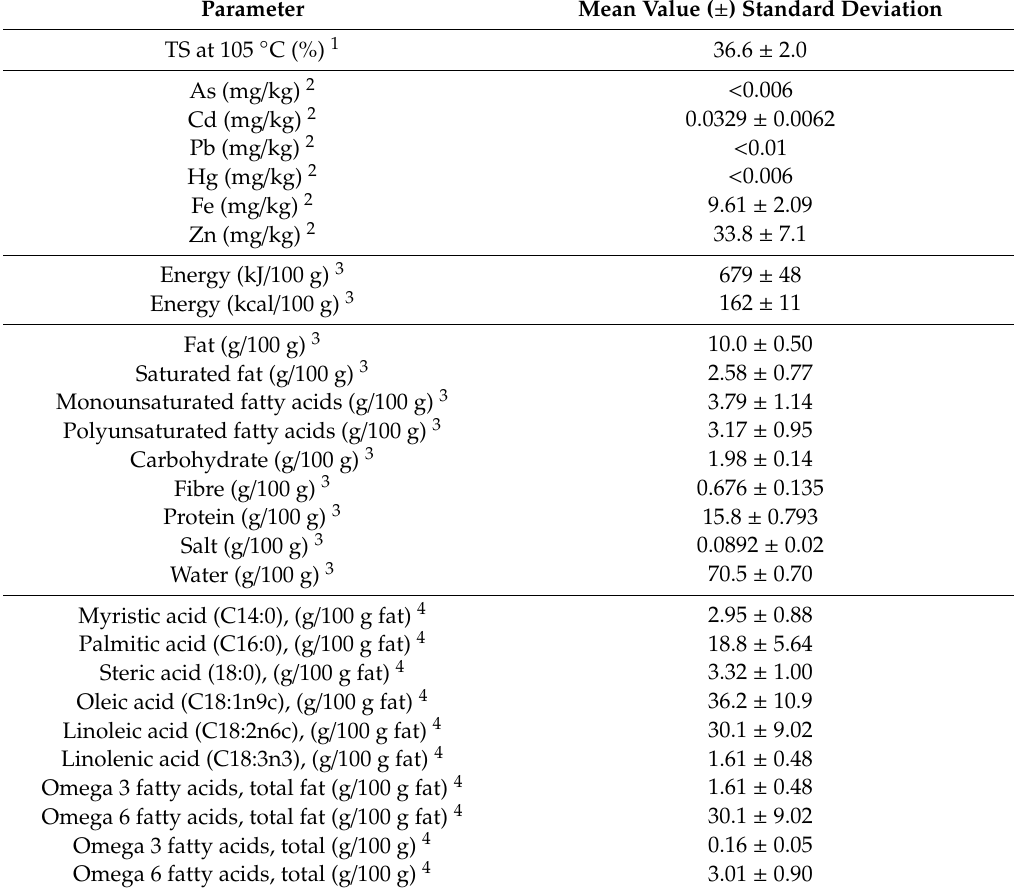
Table 1. Chemical analysis of raw material, Tenebrio molitor , analysed by ALS Scandinavia